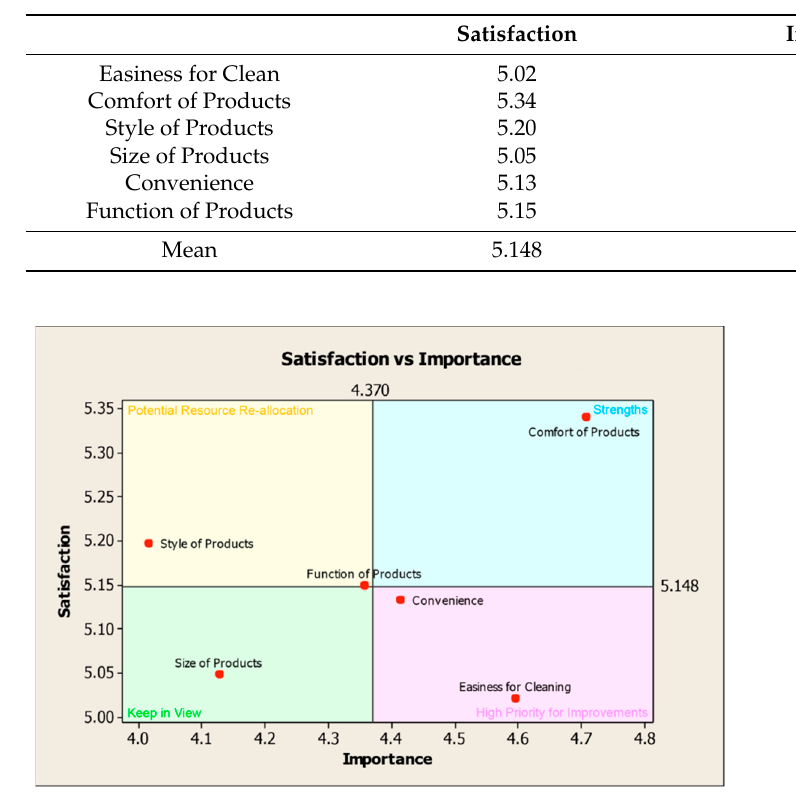
Table 3. Relative importance and satisfaction level.